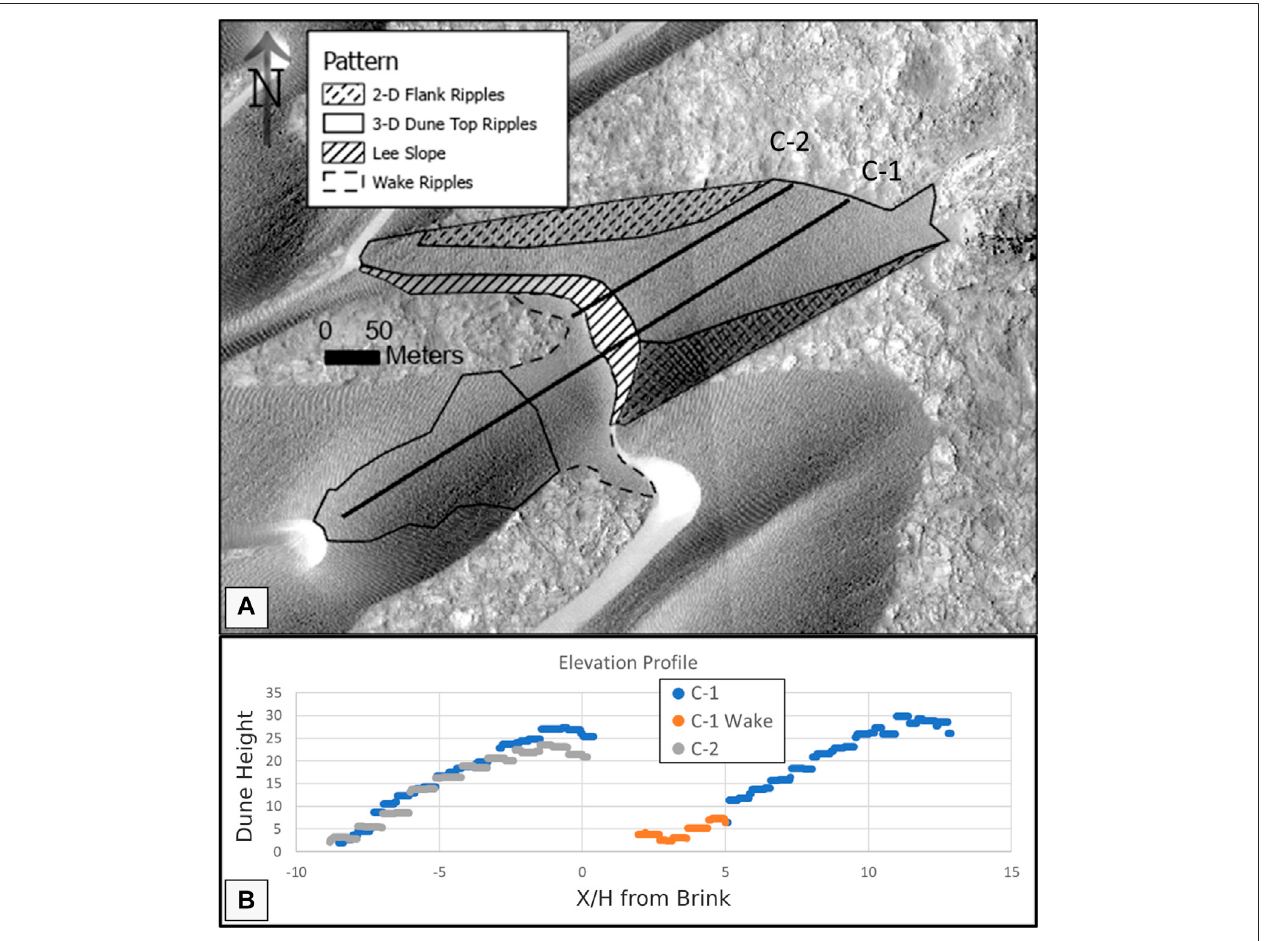
FIGURE6| ImageofDuneCwithripplesandtransectsmapped.Elevationalongeachtransectisshowninthelowerrightcorner,withleeslopesremovedforclarity andareasmappedas “ WakeRipples ” highlightedinthepro fi le.Thedistancefromthebrinkismeasuredpositiveinthedownwinddirection.Artifactsintheelevationdata are due to the spline fi t used to model the sub-dune